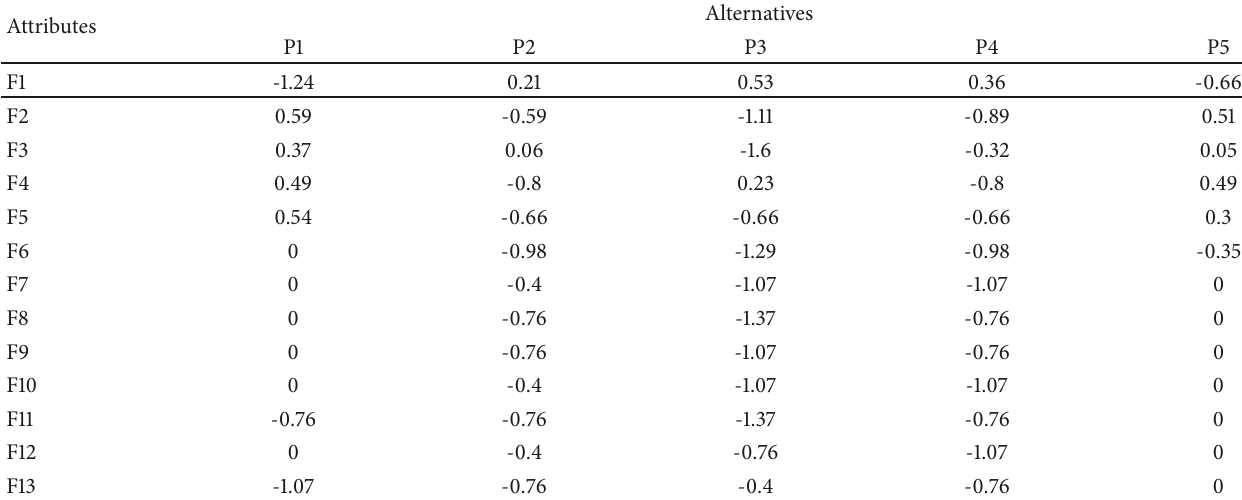
Table 3: Offline channels, property prospect value.